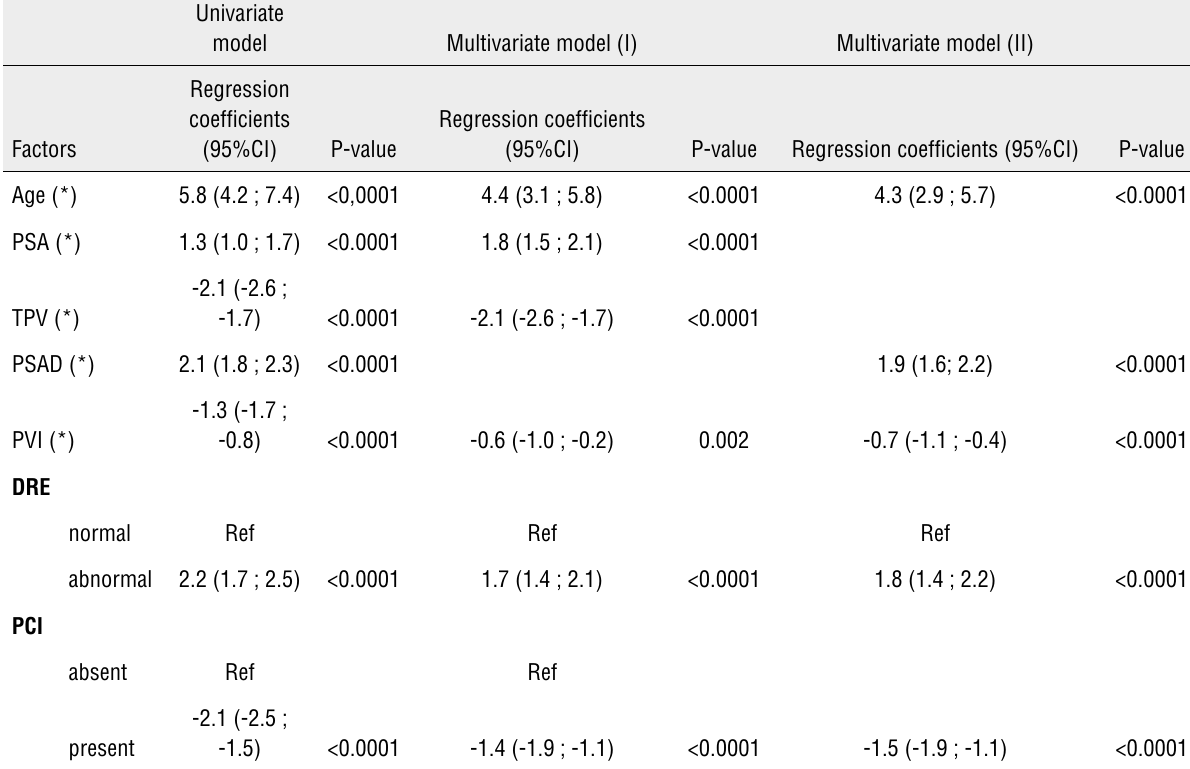
Table 2 - Linear regression models of factors predicting the number of positive cores at baseline biopsies in 945